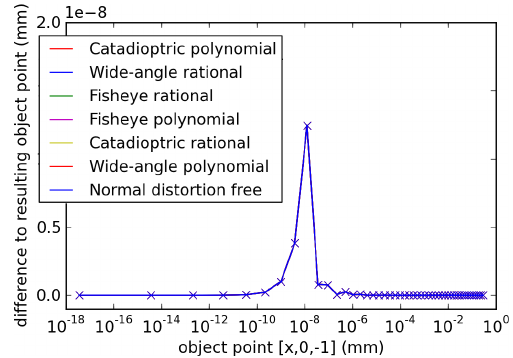
Figure 5: Numerical Stability Test; When back-projected, the lower graph shows the distance to the original points around